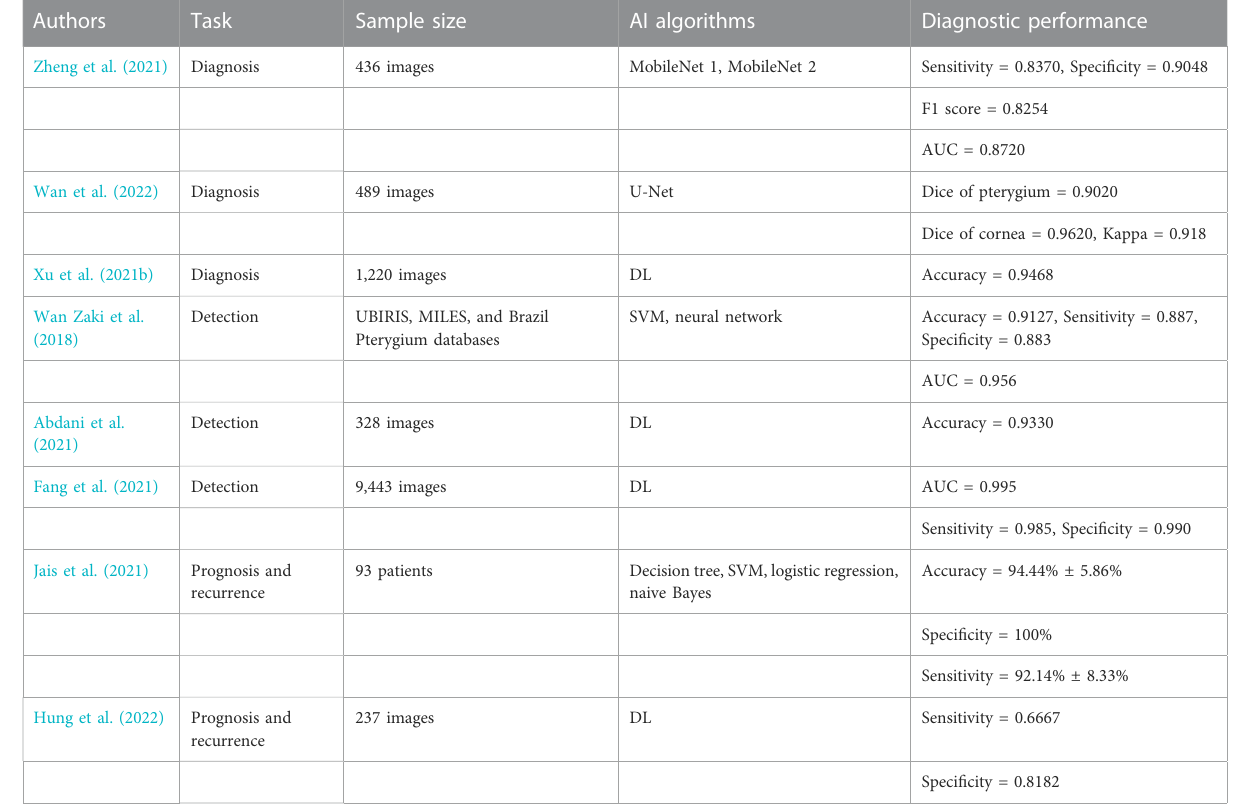
TABLE 4 Summary of application of AI models in